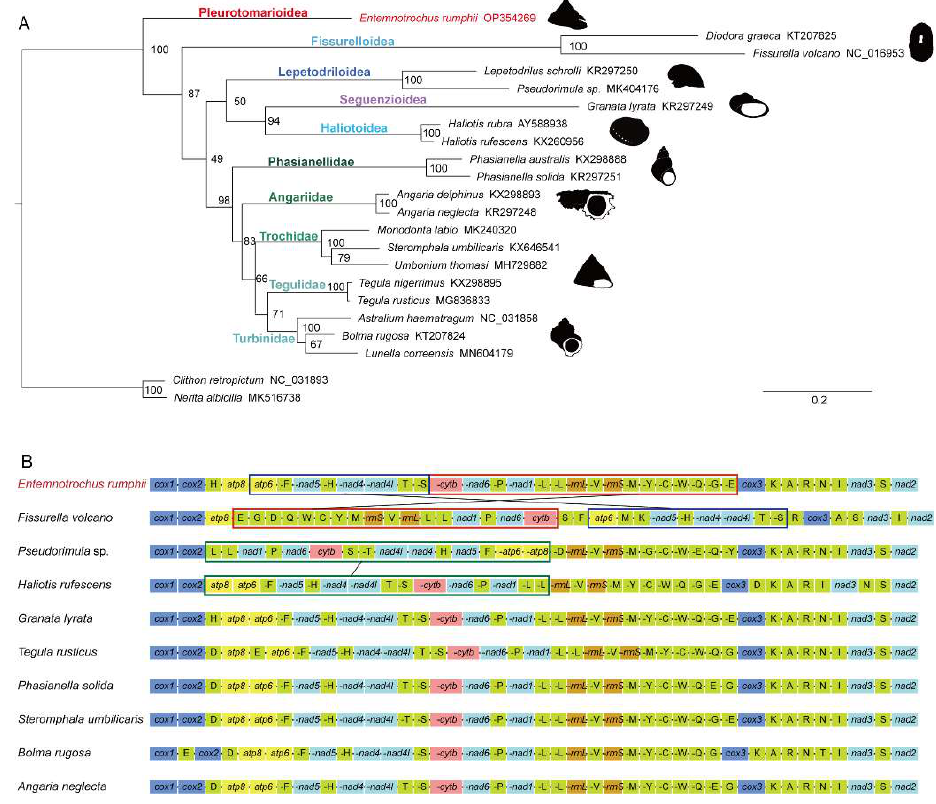
Figure 4. Phylogenetic tree of Entemnotrochus rumphii , 20 species of Vetigastropoda, and 2 outgroup species based on the amino acid sequences of 13 protein-coding genes ( A ), and protein-coding gene arrangement of 10 species in Vetigastropoda ( B ). In the phylogenetic tree, bootstrap support values (BS) are shown on each node. The arrangement graph is shown with iTOL (https://itol.embl.de/, accessed on 15 October 2022) and the boxes in the same color show identical gene blocks.